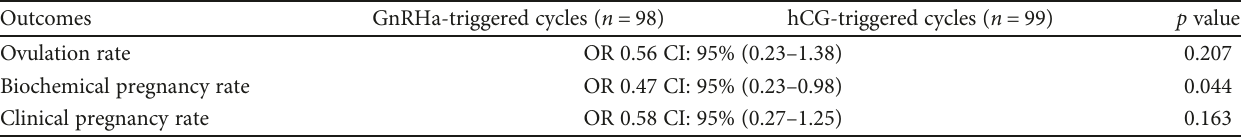
Table 3: Intervention outcomes after adjustment for BMI and infertility duration in GnRHa- and hCG-triggered cycles.